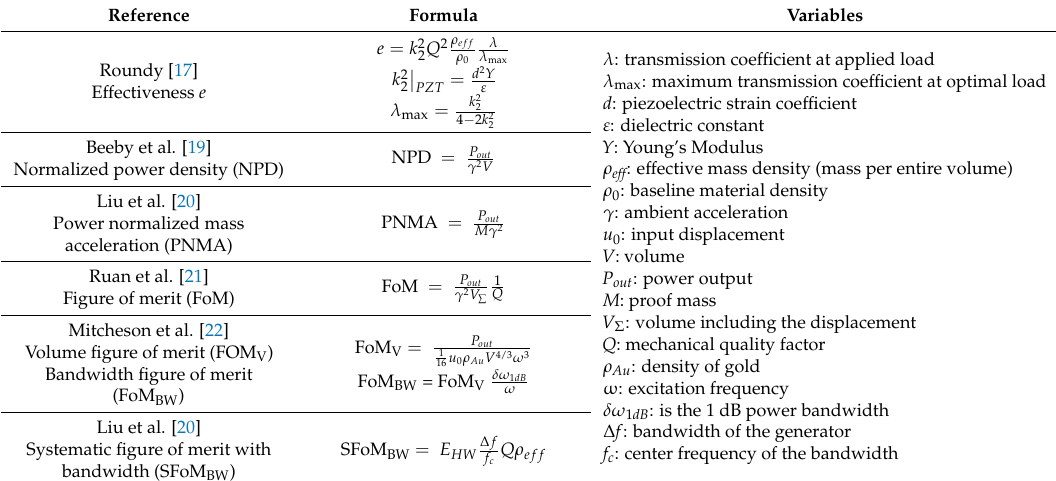
Table 2. Figures of merit to evaluate between the vibration energy harvesters.